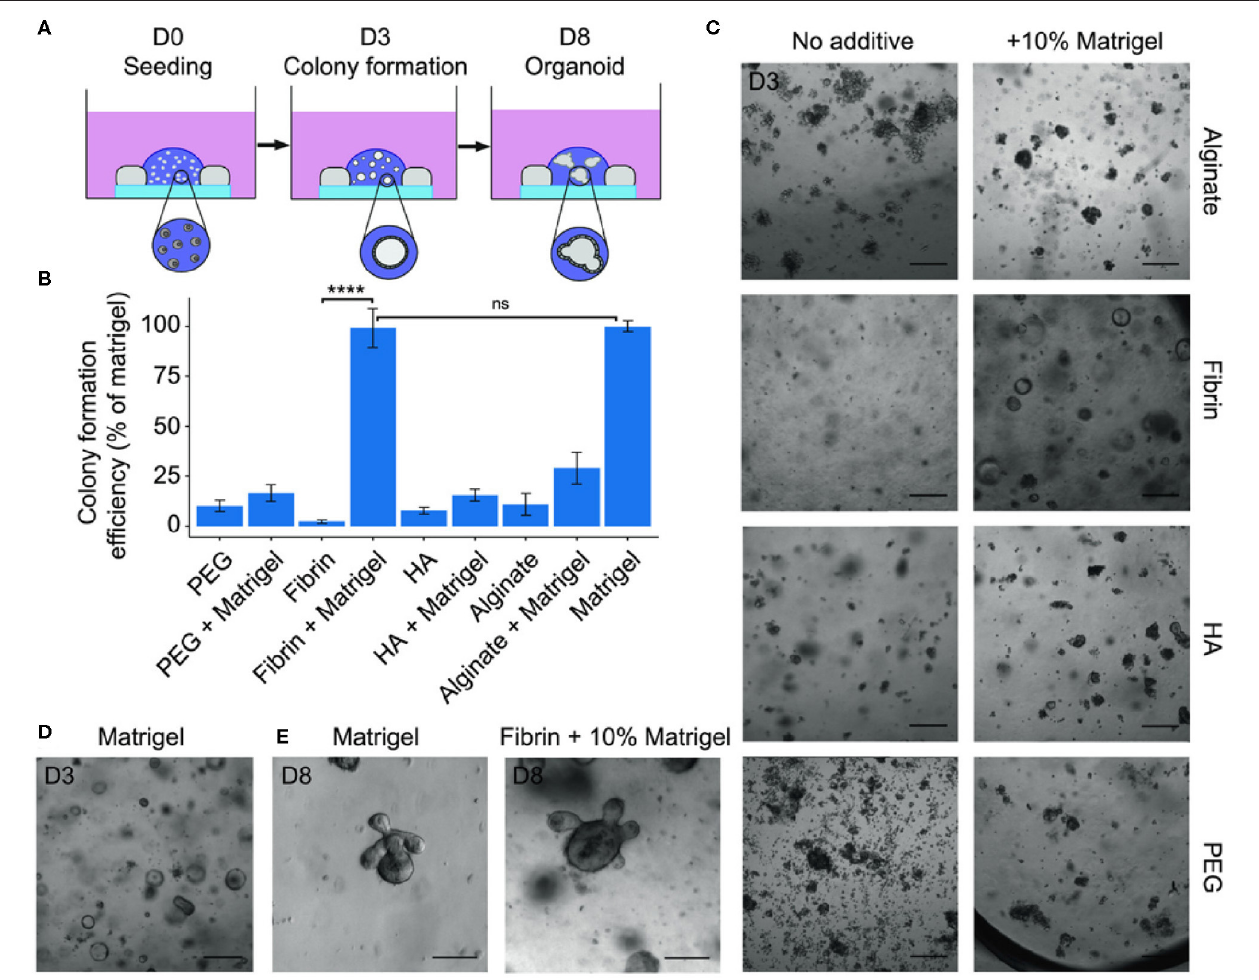
FIGURE 4 | (A) Scheme of seeding assay showing the hydrogel inside a silicone mold on a glass cover slip. Small intestinal stem cells first grow as cystic spheres as seen at day 3 (D3) followed by the formation of budding organoids after ∼ 1 week. (B) Quantifications of colony formation efficiency of mouse small intestinal stem cells in different hydrogels with or without 10% Matrigel. Data are expressed as a percentage of the colony count in Matrigel (100%). (C,D) Representative brightfield images of the cultures in the different hydrogels and Matrigel control. Scale bars: 200 µ m. (E) Budding organoids as seen in Matrigel and in fibrin + 10% Matrigel after 8 days. Scale bars: 100 µ m. Reproduced under the CC BY Creative Commons Attribution 4.0 International License (Broguiere et al.,